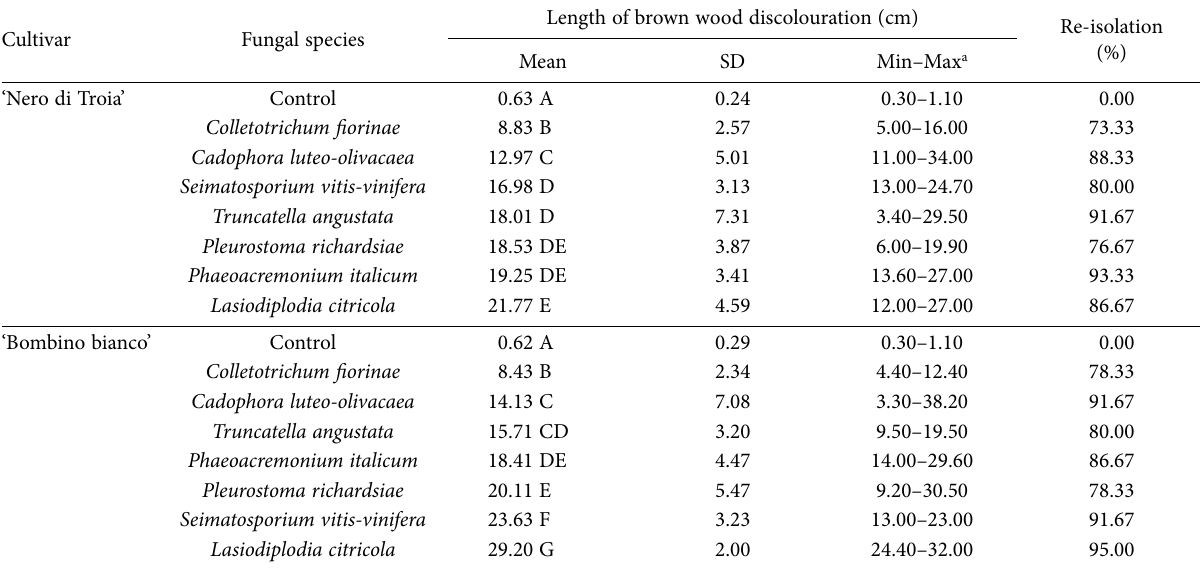
a Minimum and maximum values detected (18